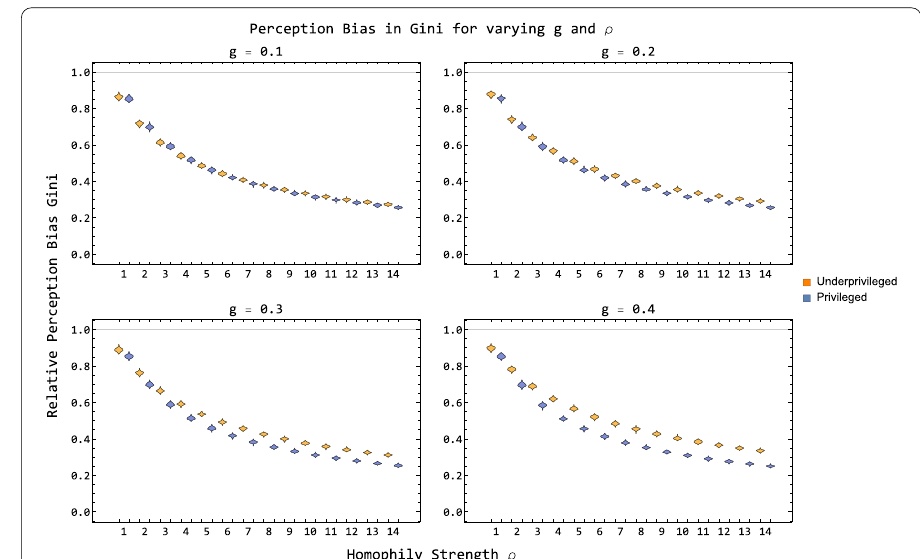
Fig. 8 Violin plots of (normalised) perceived Gini coefficients for various ρ and g according to privilege class. Perceptions are displayed in relation to the actual Gini of G ≈ 0.5